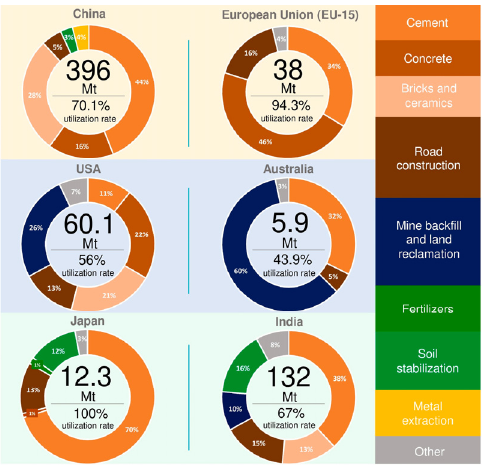
Figure 2. Utilization ratio and utilization mode of CFA in major countries in the world